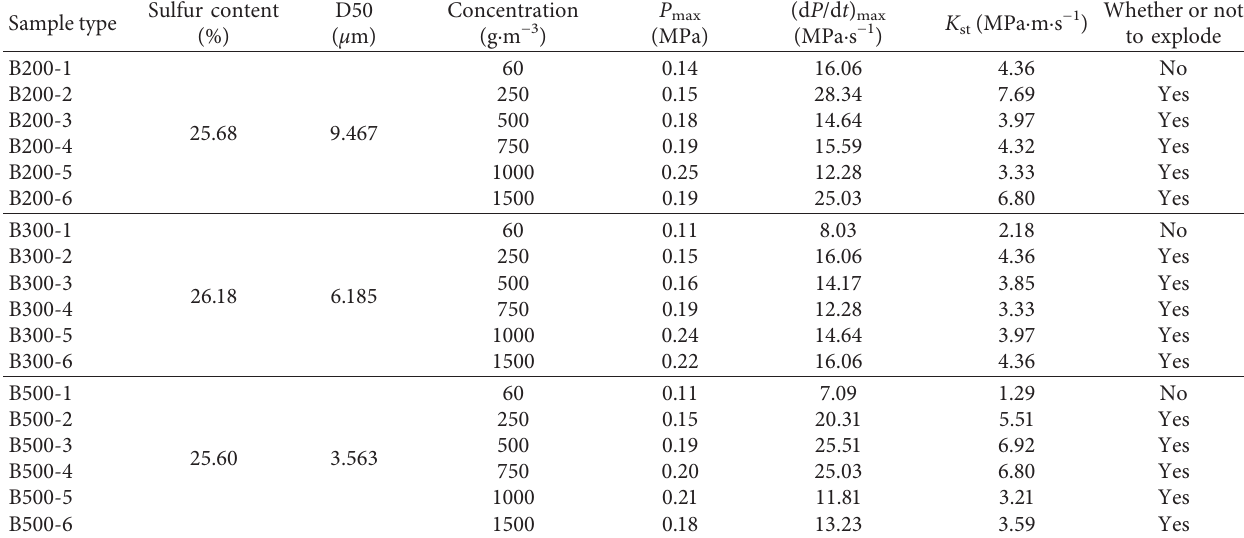
Table 5: Summary of explosion pressure data for B group.